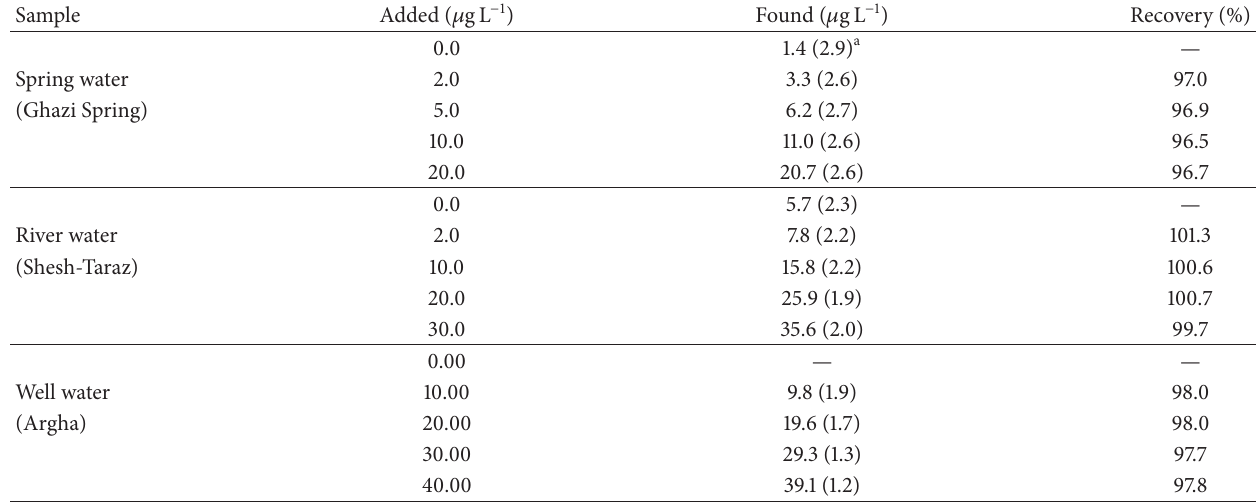
Table 4: Application of the proposed method for the determination of U(VI) in 1500 aliquots of environmental water samples. Sample Spring water